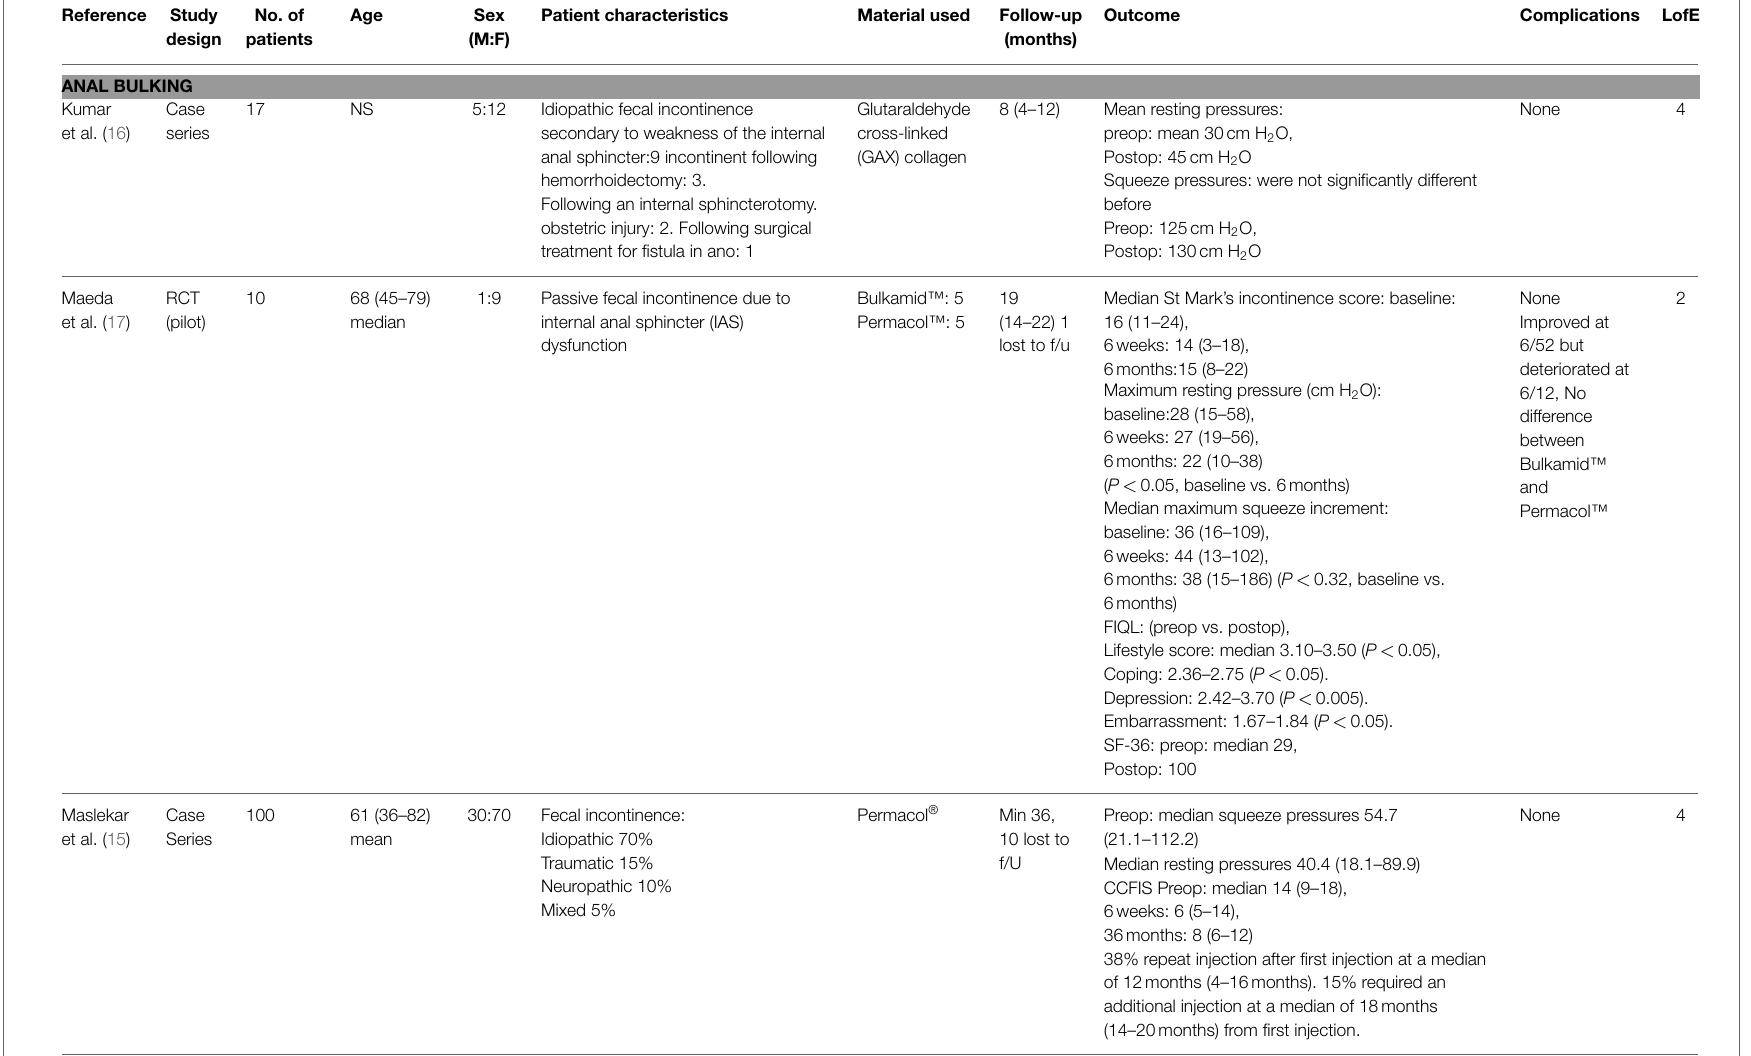
TABLE 1 | Biologic materials augmenting the anal sphincter for the treatment of fecal incontinence . Reference Study